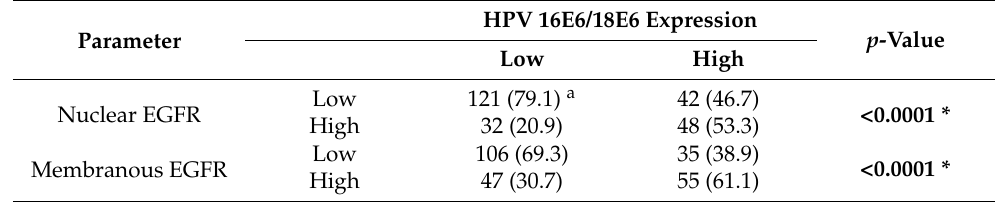
Table 1. Correlation of HPV 16E6/18E6 expression and differentially located EGFR expression in 243 non-small-cell lung cancer